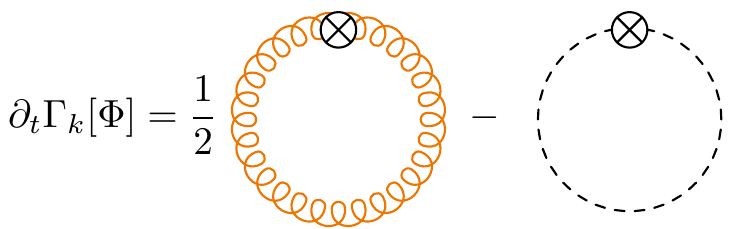
Figure 2: Depiction of the flow equation for the effective action, eq. (59). Spiralling orange lines depict the full field-dependent gluon propagator 〈 AA 〉 = G [ ¯ A , φ ] , dashed back lines depicted the full field-dependent ghost c aa = G [ ¯ A , φ ] , where the subscript stands for connected part. The propagator 〈 c ¯ c 〉 c c ¯ c circled cross stands for the regulator insertions ∂